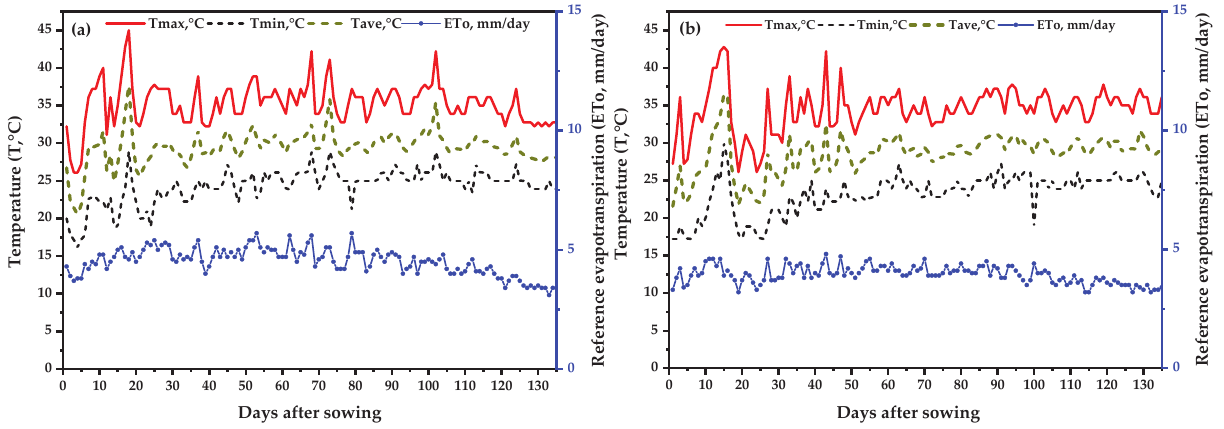
Figure 4. Daily temperature and reference evapotranspiration patterns during the growing seasons of ( a ) 2019 and ( b ) 2020. T max , T min , and T ave indicate the maximum, minimum, and average temperature, respectively.